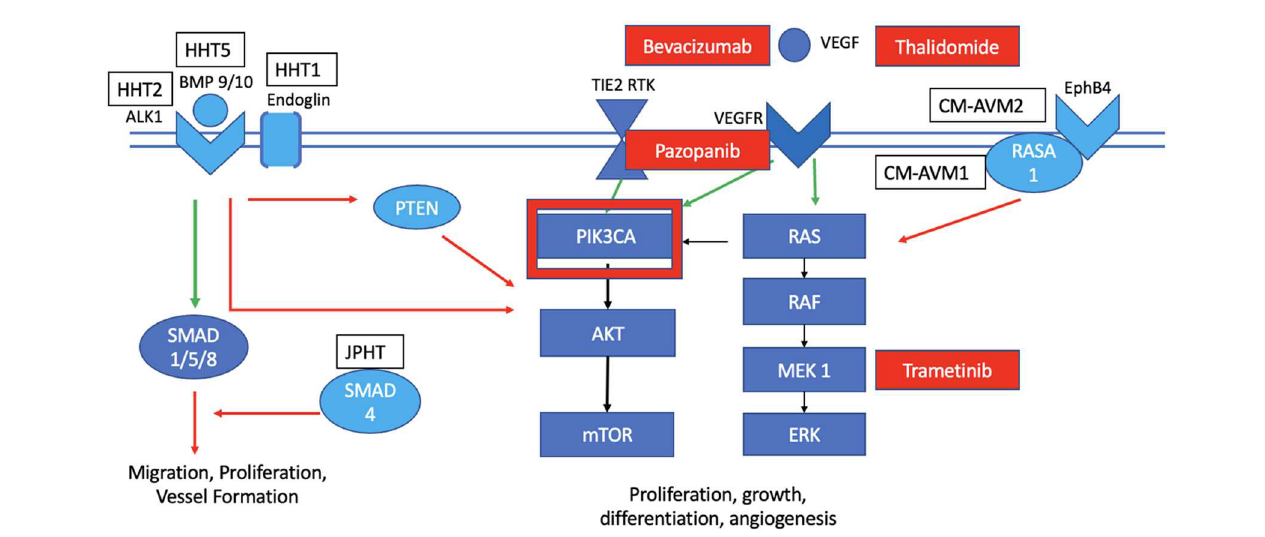
FIGURE3 Mutations and targeted therapies for slow-flow malformations. HHT1 is known to have multiple affected loci in the BMP signaling pathway that generally act to inhibit the PIK3CA pathway in the wild-type state. CM-AVM 1 is characterized by a LOF mutation in RASA1, while CM-AVM2 has the mutation in the EphB4; both activate the KRAS pathway in the wild-type state. Targeted therapies for HHT include bevacizumab, pazopanib and thalidomide. There is a potential to also explore PI3KCA with Alpelsib for HHT. Targeted therapies for CM-AVM include Trametinib, while those for sporadic AVMs include bevacizumab, thalidomide, and